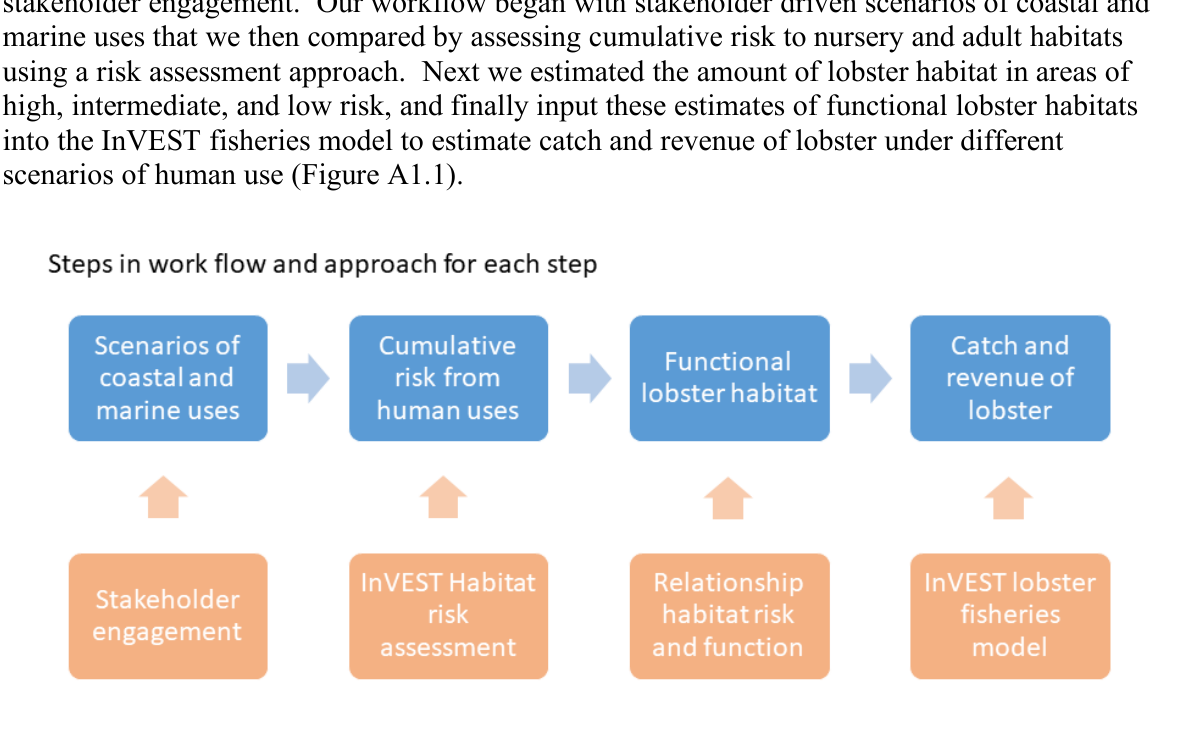
Figure A1.1 : Conceptual diagram showing the steps in the workflow (blue boxes) and approach taken within each step (orange